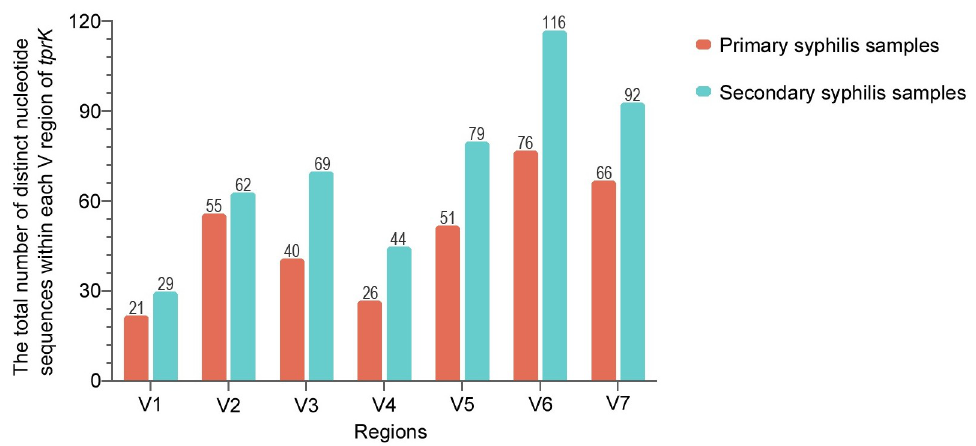
Fig 1. A sum of distinct nucleotide sequences within each V region of tprK from each strain in the samples at different stages. The data of tprK from primary syphilis samples were obtained in previous studies [17].